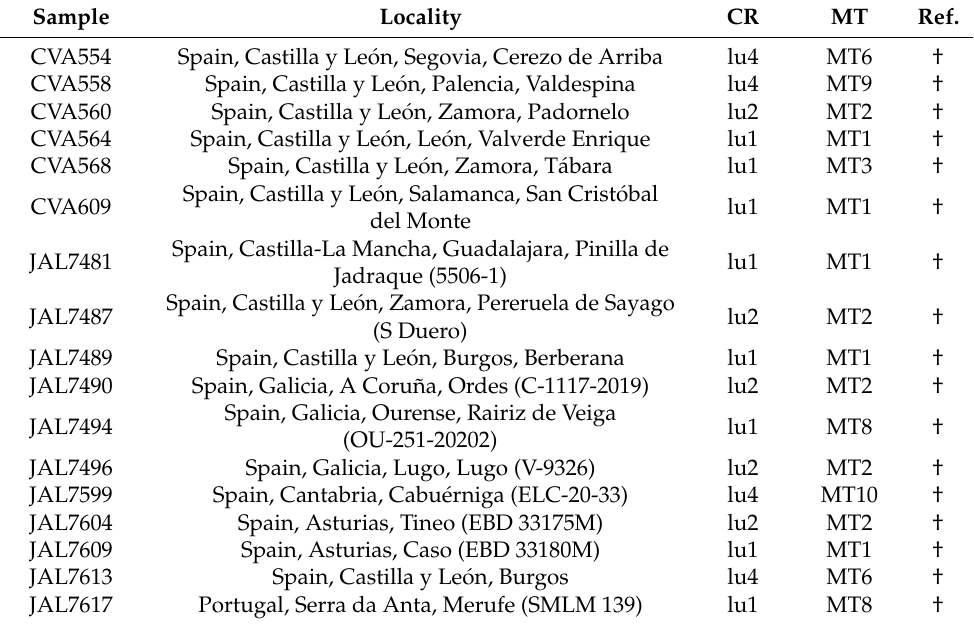
Table 2. Modern Iberian wolves. Sample is lab ID or GenBank accession number, locality; CR is haplotype for the 5 (cid:48) end of the control region and MT for the whole mitogenome except the control region; Ref, reference from which data has been obtained, †, this